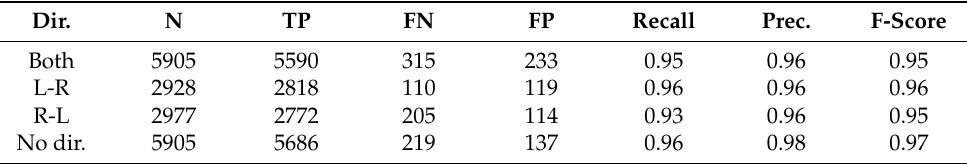
Table 2. Vehicle detection results in four scenarios: with detection of the direction ( Both ), for a single direction (left-to-right or right-to-left) and without detecting the direction ( No dir. ).